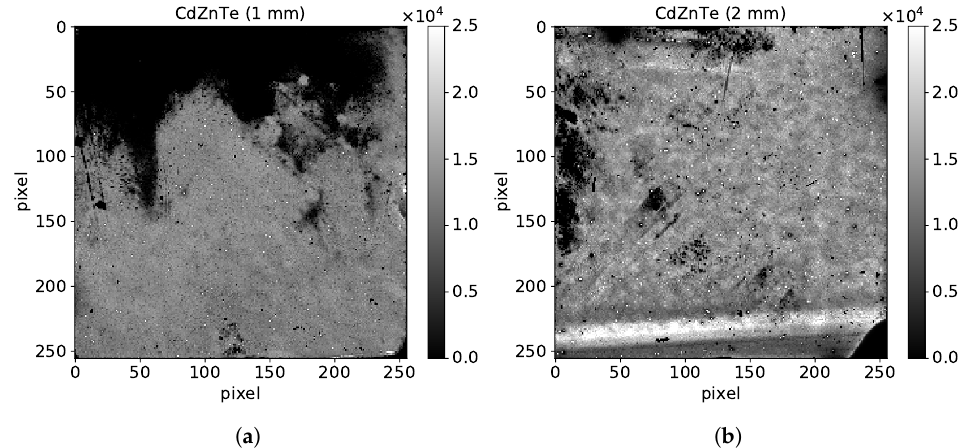
Figure 6. Raw flood images recorded with CdZnTe sensors of 55 µm pixel pitch and a thickness of ( a ) 1 mm and ( b ) 2 mm. The energy threshold was set at half of the characteristic energy of Source